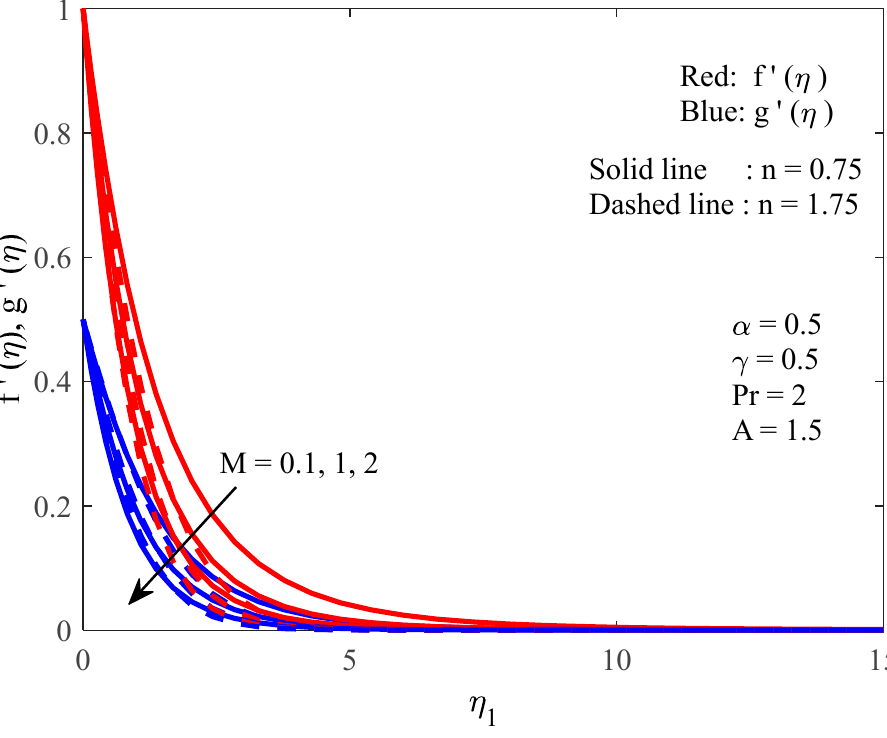
Figure 2. The bidirectional (axial and transverse) velocity distribution profile with the influence of M .